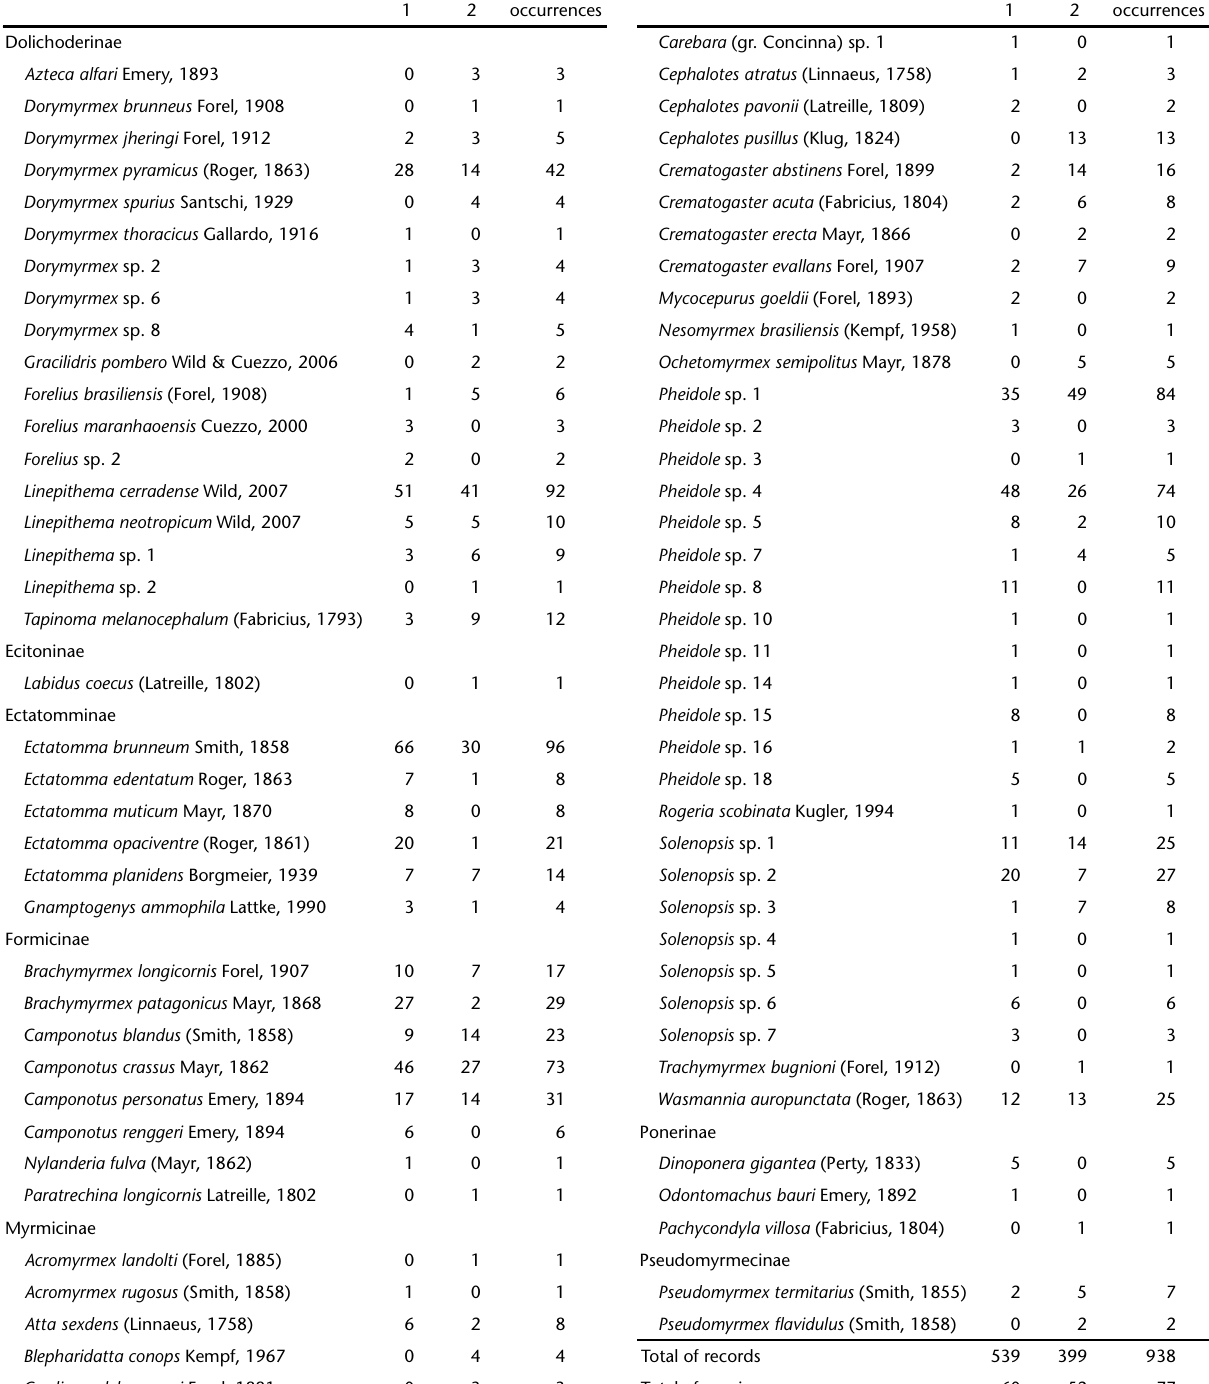
Table I. Ground-dwelling ant species recorded (total number of occurrences) at sardine baits (N = 320 per reserve; see Material and Methods) set along eight 200 m transects in two reserves of Cerrado in Balsas, Maranhão, northern Brazil. Reserve